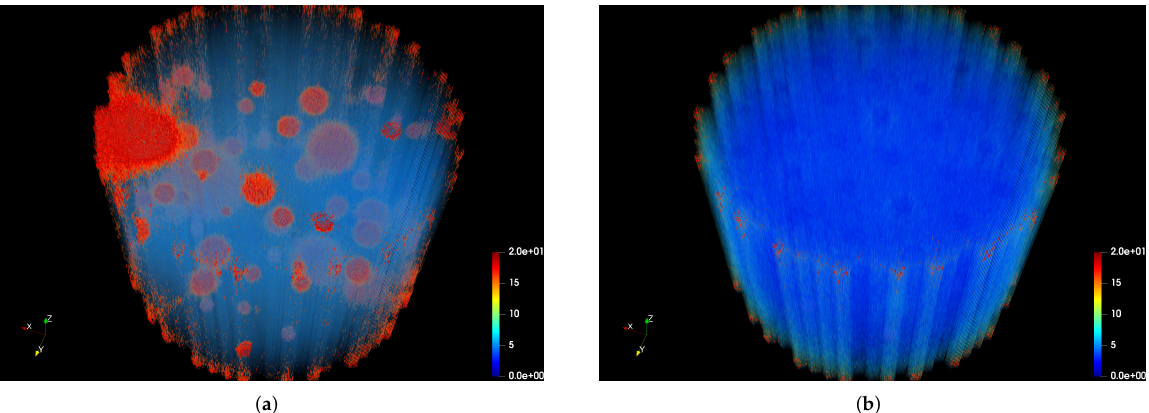
Figure 16. 3D distribution of relative error in percents for suboptimal ( a ) and for improved precursor sampling ( b